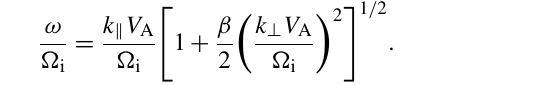
Figure 5. One-dimensional slice of the energy spectrum over the spacecraft-frame frequencies at a streamwise wavenumber of 0.015radkm − 1 from Fig. 4 (in black) and a fitted curve by the Breit–Wigner distribution (in gray) for ω 0 = 0 . 49rads − 1 and γ = 0 . 08rads − 1 .